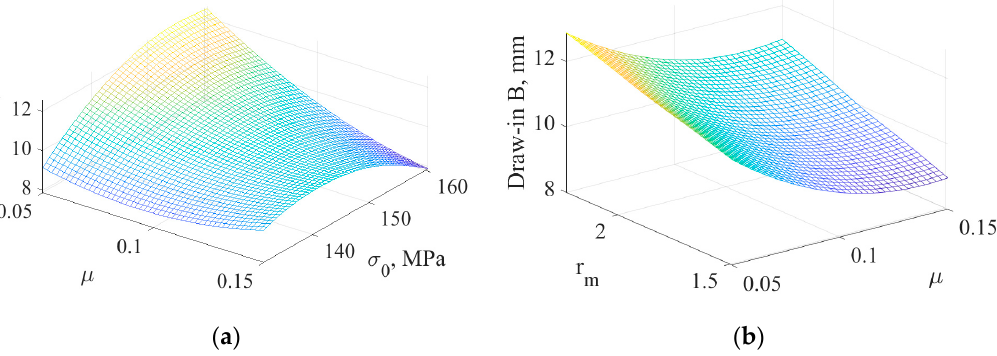
Figure 16. Metamodel of the draw-in at point B for a fluctuation in ( a ) µ and σ 0 and ( b ) µ and r m .